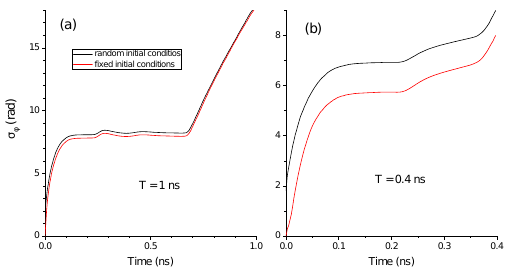
Figure 6. Standard deviation of the phase as a function of time for ( a ) T =1 ns, and ( b ) T =0.4 ns. Results for random and fixed initial conditions are plotted with black and red lines,